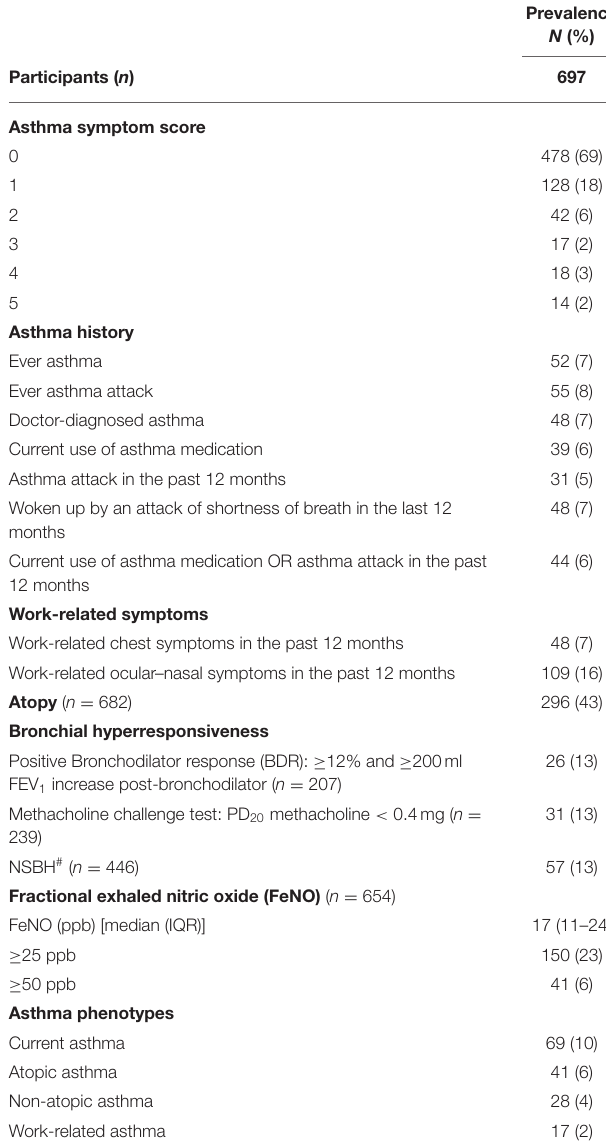
TABLE 1 | Prevalence of asthma-related outcomes in health workers working with cleaning